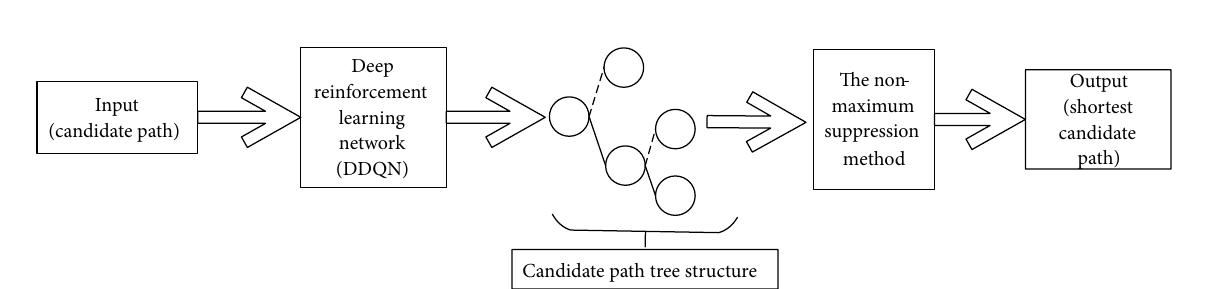
Figure 5: The overall structure of TDDQN algorithm.